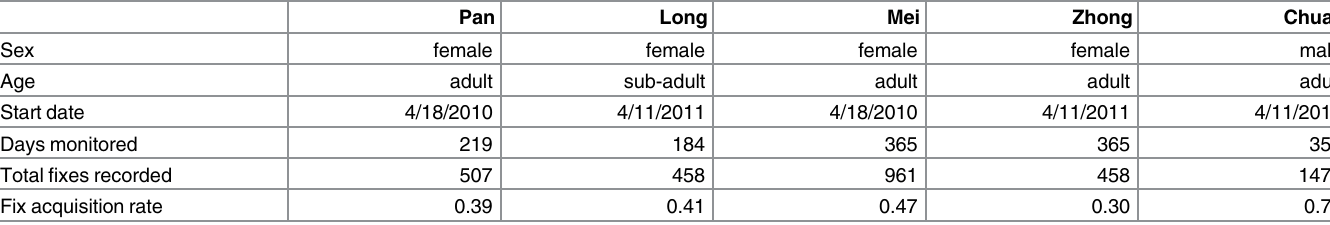
Table 1. Summary of study pandas and GPS collar performance over the one year period included in this study. Pan